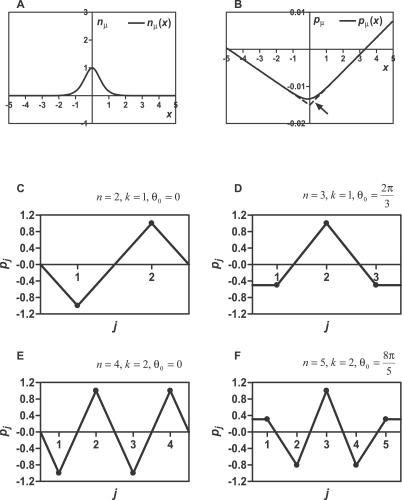
Stability Analysis of Multiple-Peak SolutionWe seek growable perturbations (n
μ, p
μ) for the periodic solutions as discussed in the text. First, we show the perturbations for the one-peak solution, which are derived from Equations 11a and 11b, without consideration of boundary conditions: (A) n
μ(x); and (B) p
μ(x).(A,B) We used the following values: a
1 = 0.5, a
2 = 2.2, Du = 0.1, Dv = 1,
N̄ = 2. Because we cannot determine the values of μ and C
1 without boundary conditions, we arbitrarily set μ = 0.06 and C
1 = 0.3 here. The dashed line with an arrow in (B) indicates the approximation to a piecewise linear function. Next, we show the perturbations for multiple-peak solutions. We can describe a perturbation by a set of pj, where pj is the value of pμ at the center of the jth peak. As shown in the text, we obtain pj as
= cos[(2kπ/n)j + θ0], where k is an integer (1 ≤ k ≤ n/2), corresponding to a mode, and θ0 is an arbitrary constant.
(C–F) Show the most growable perturbations for two-, three-, four-, and five-peak solutions, respectively. For each n, the mode, k, that gives the largest value to μ, is determined by μ(k) = [(12n
3
Dva
2)/(L
3

N̄
2
b)]sin2(kπ/n).